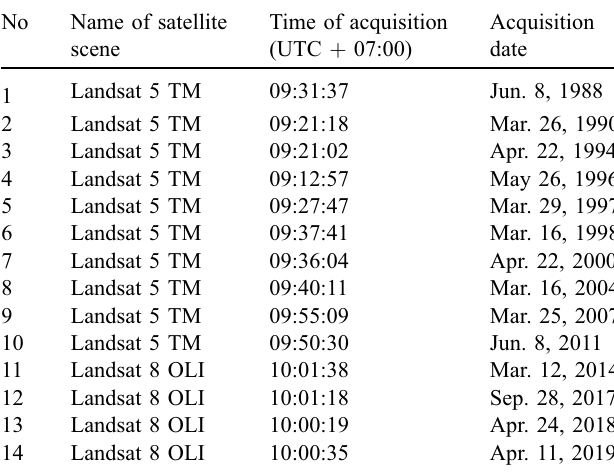
information for the satellite image data sets including sensor type, acquisition date and time are presented in Table 1.